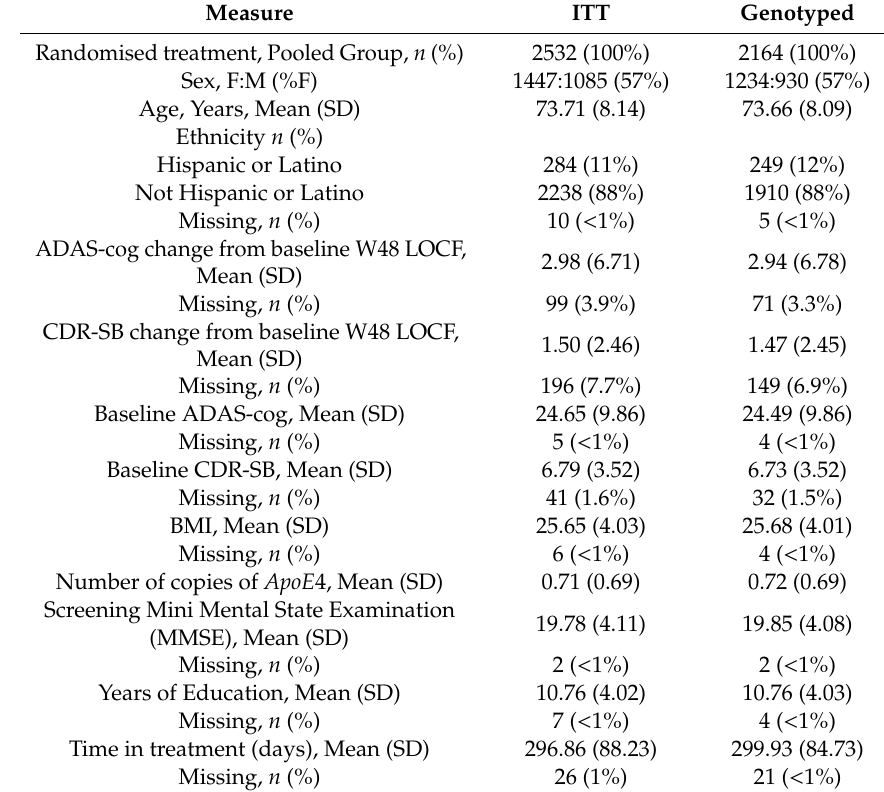
Table 1. Demographic data across treatment arms in Intent to Treat (ITT) and genotyped populations: Percentages may not total 100% due to